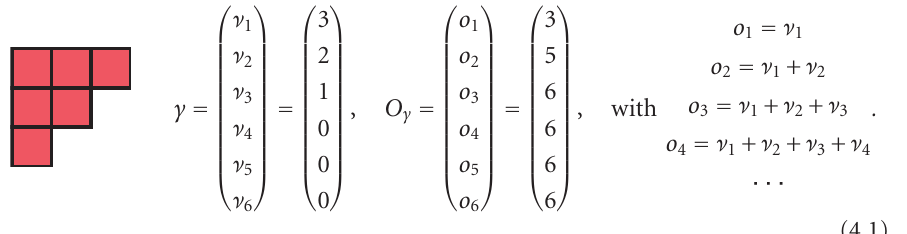
the set of all possible diagrams for n boxes only if n ≤ 5, but a partial order, if n > 5